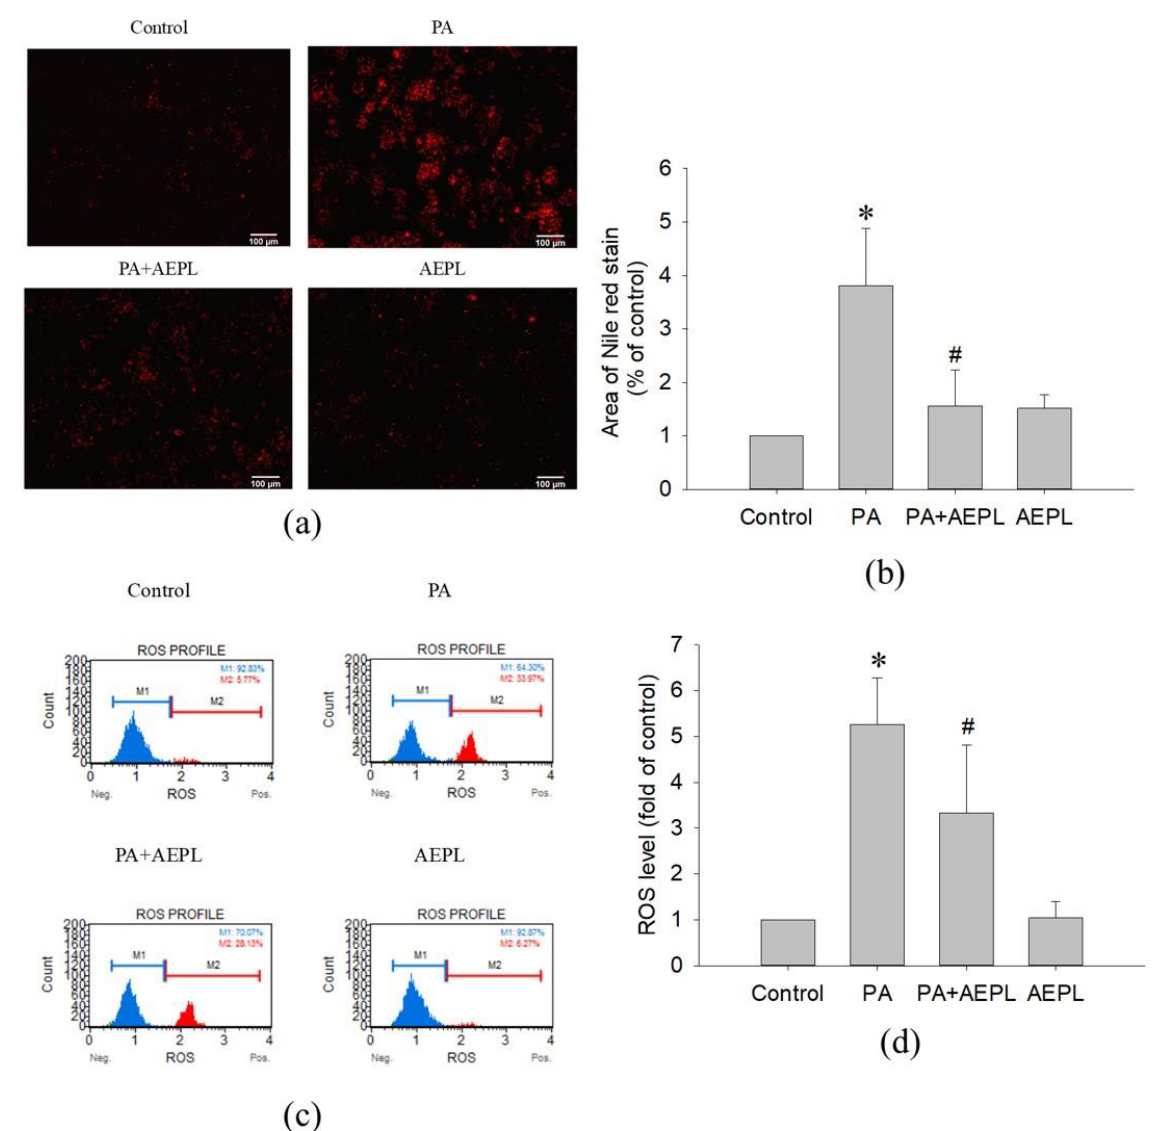
Figure 3. AEPL decreased PA-induced lipid accumulation and ROS production. HepG2 cells were treated with 0.3 mM PA in presence or absence of AEPL for 24 h. ( a ) TG accumulation with different treatment was performed by Nile red staining. Scale bar, 100 µ m. ( b ) Quantification of fluorescent area by using ImageJ. ( c ) Intracellular ROS levels were stained with dichlorofluorescin diacetate (DCFH-DA) and analyzed by flow cytometry. M1 indicated DCF-negative cells and M2 indicated DCF-positive cells. ( d ) The percentage of DCF-positive cells were calculated and compared with the control group. All data were performed with three independent experiments. * p < 0.05 vs. control cells; # p < 0.05 vs. PA-treated cells.